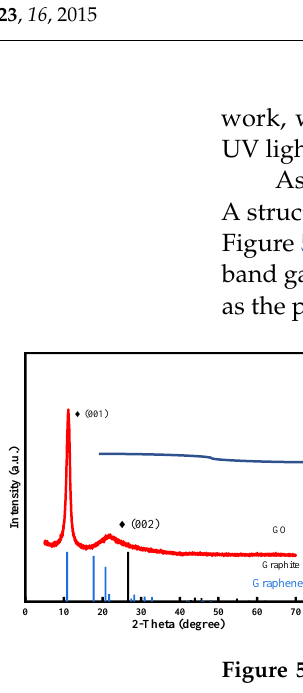
7 of 14 Figure 4. Structural analysis of PANI under different photopolymerization conditions: ( a ) FT-IR spectra and ( b ) UV spectra. As a result, doping GO can markedly improve the visible light utilization of TiO 2 . A structural analysis of PANI under visible photopolymerization conditions is shown in Figure 5. The 1GO:2.5Ti expanded the absorption range of visible light for TiO 2 , and the band gap energy was less reduced compared to other ratios of catalysts, so it was selected as the photocatalyst for polyaniline under visible light. The XRD spectra were measured from 5° to 70°. Figure 5a shows the obvious diffrac- tion peaks of GO at 2θ = 10.08° and 2θ = 21.8°. Compared with carbon (JCPDS No 26-1077) and C60 (JCPDS No 44-0558), the lattice defects of GO prepared using Hummers’ method were slightly greater than those of graphite, and a crystal phase for graphene was found. Figure 5b also shows that traces of the modified catalyst product ideally coincided with the grap hite peak (2θ = 23.37°) and Pan’s [47] characteristic peak (2θ = 20.04°). According to the literature report, the amorphous PANI diffusion mostly occurs around 19°, and the characteristic diffraction peak associated with the interplanar spacing between aniline monomers is at approximately 25° [47]. The product from the photopolymerization with